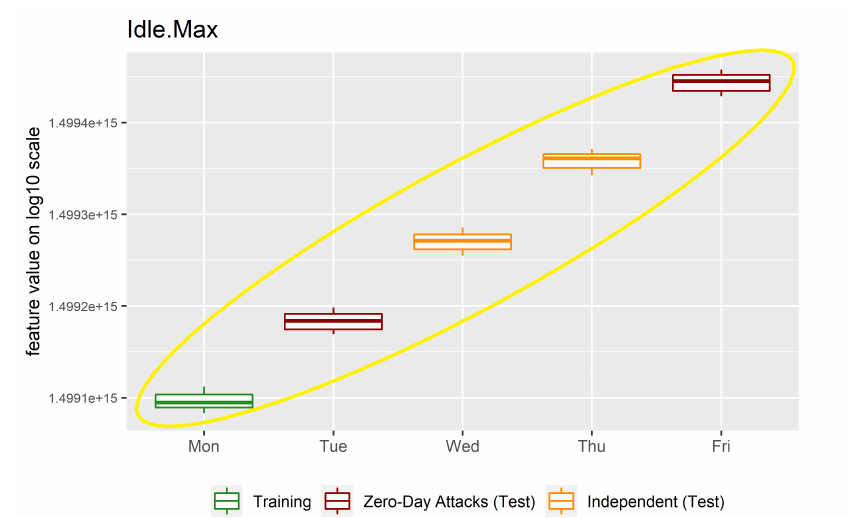
Figure 1. Boxplot of the feature “Idle